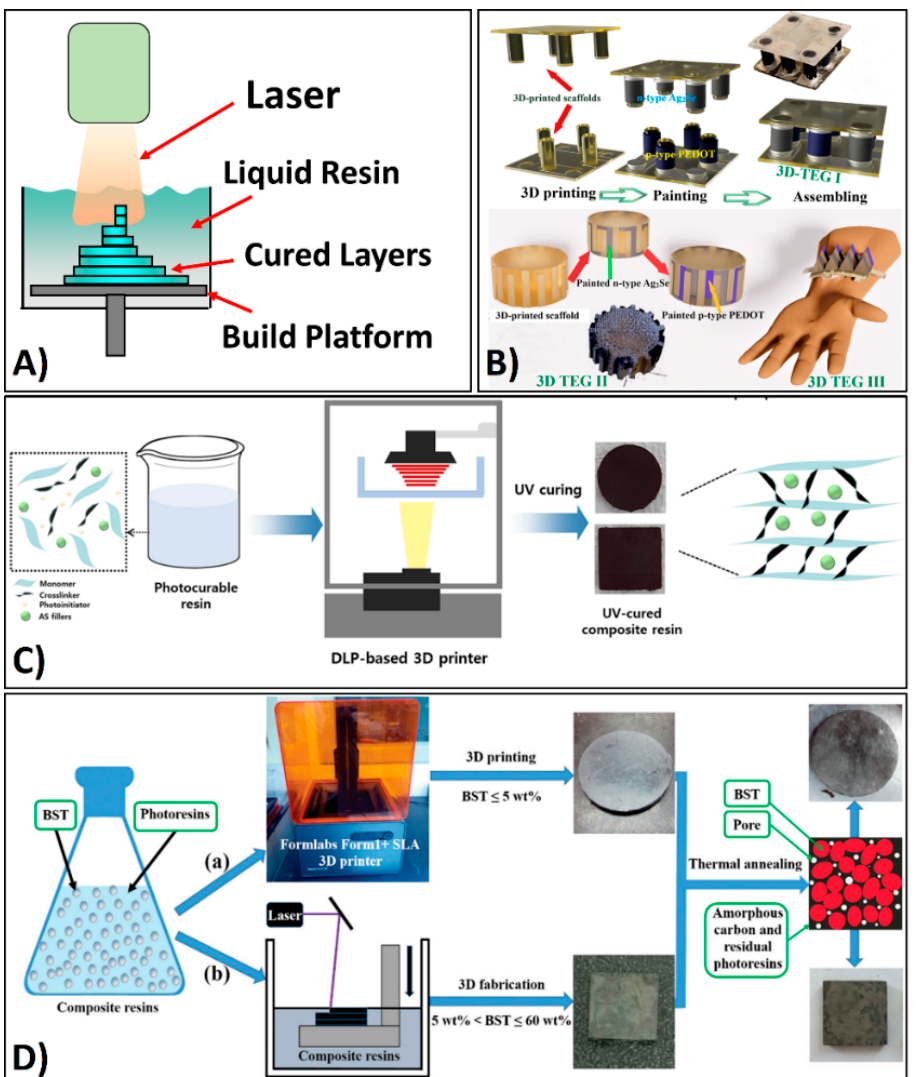
Figure 3. ( A ) Working principle of vat photopolymerization, ( B ) Quasi-vat photopolymerization printed β -Ag 2 Se-PEDOT TE generators fabricated by Mallick et al. [28], ( C ) Bulk β -Ag 2 Se TE struc- tures made by Park et al. [62], ( D ) Bulk Bi 0.5 Sb 1.5 Te 3 samples made by He et al. [59] (Reproduced with permission)